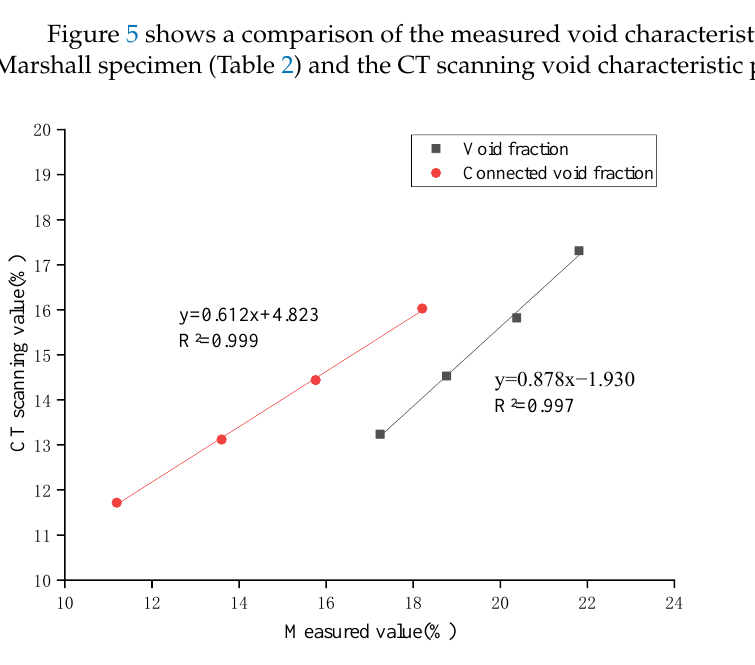
Figure 5. Comparison of the measured and CT scanning values of the void characteristic parameters of EPA-13.